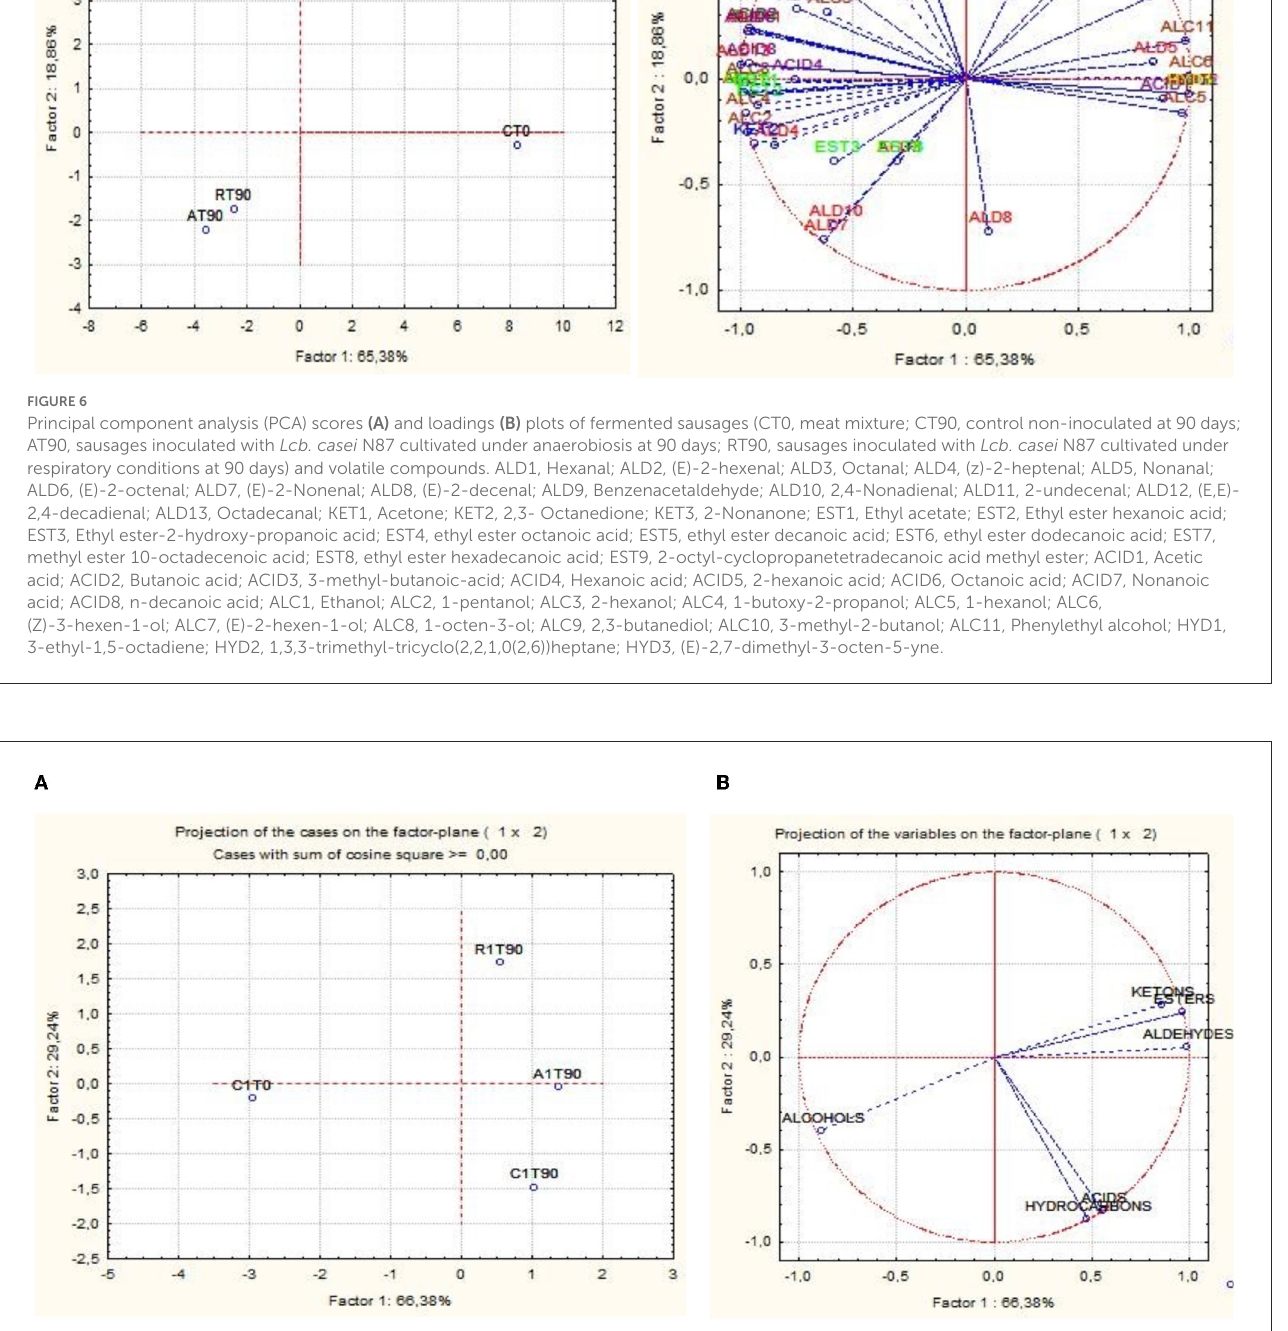
FIGURE7 Principal component analysis (PCA) scores (A) and loadings (B) plots of fermented sausages (CT0, meat mixture; CT90, control non-inoculated at 90 days; AT90, sausages inoculated with Lcb. casei N87 cultivated under anaerobiosis at 90 days; RT90, sausages inoculated with Lcb. casei N87 cultivated under respiratory conditions at 90 days) and groups of volatile